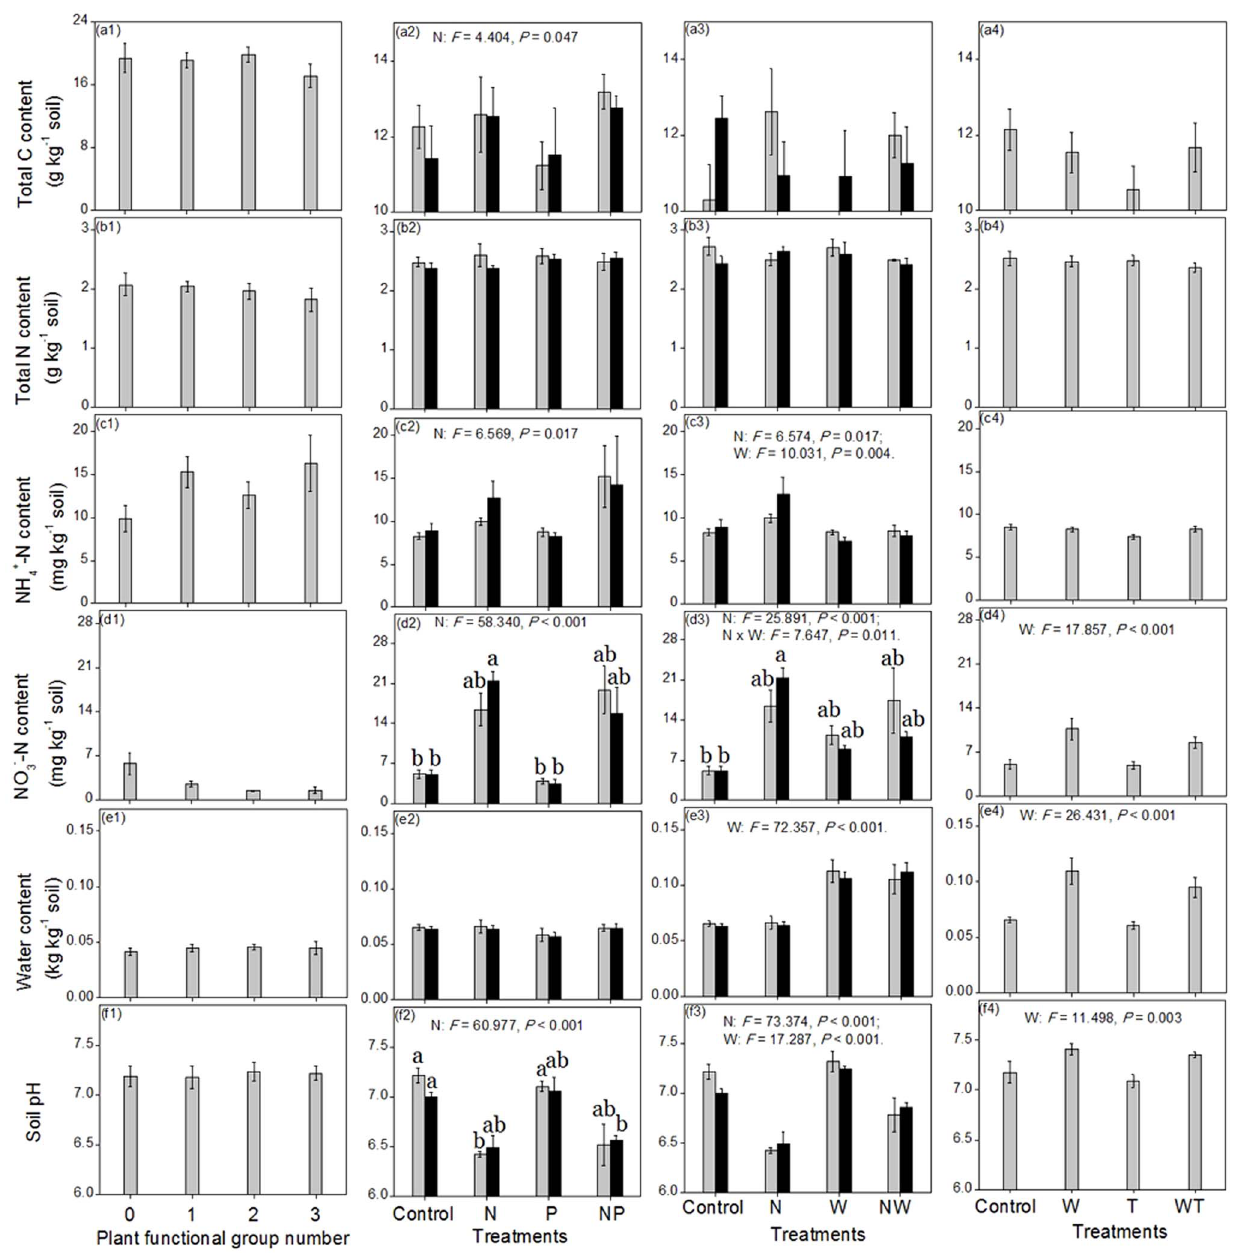
Figure 1. The effects of different treatments on six soil physicochemical indexes. Error bars represent one standard error. For clarity, only the statistical results with P , 0.05 are shown. 0, 1, 2 and 3 for the x axis in a1–f1 represent the remained PFG number. M, N, P, W and T in a2–f4 represent the treatments of simulated mowing, N addition, P addition, watering, and warming, respectively. In a2–f2 and a3–f3, gray and black columns represent the treatments without and with mowing, respectively. There are 5, 4, 4 and 6 replicates for a1–f1, a2–f2, a3–f3 and a4–f4, respectively.